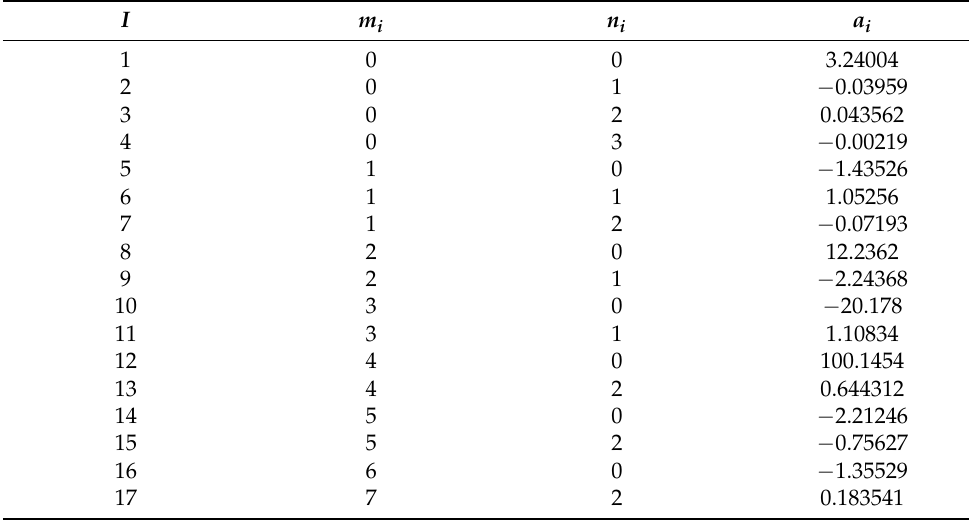
Table A7. Coefficients for Equation (A41)